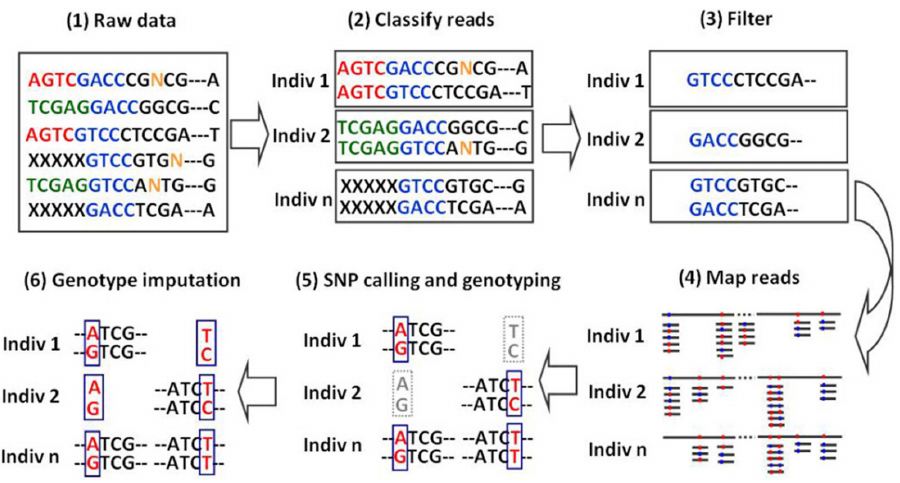
Figure 2. Diagram of iBLUP pipeline. (1) Blended raw data were generated from the same flow cell lane. (2) Raw data were assigned to individuals according to the barcode. (3) Assigned reads were filtered for high quality reads according to several rules, including trimming the barcode and the last low quality base etc. (4) Filtered reads were aligned with the reference sequence. (5) SNP calling and genotyping were done according to the mapping results. (6) Missing genotypes were imputed by the iBLUP algorithm.